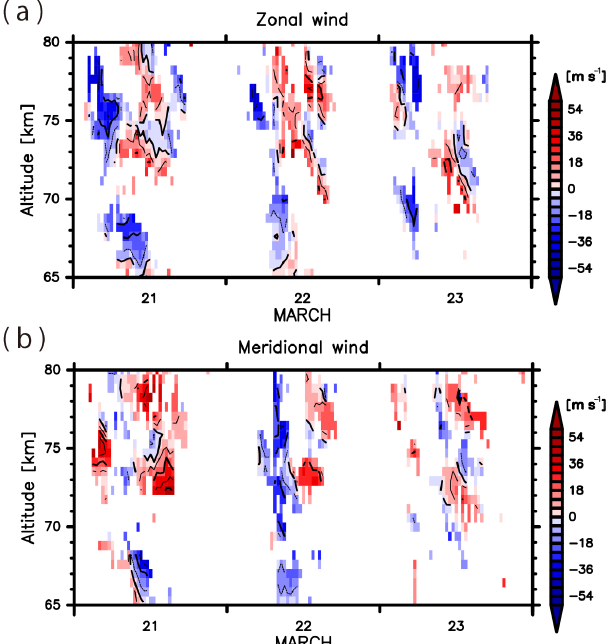
Figure 3. Time–altitude cross sections of (a) zonal wind compo- nents and (b) meridional wind components observed by the PANSY radar at Syowa Station for the period from 21 to 23 March 2015. The contour intervals are 12ms − 1